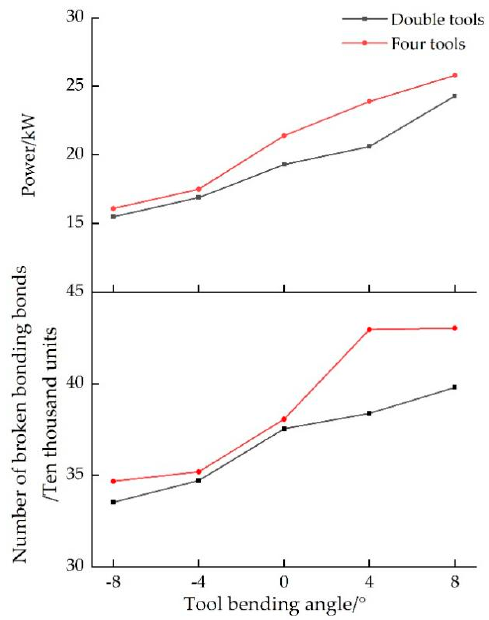
Figure 13. Influence of tool structure parameters on test indexes.